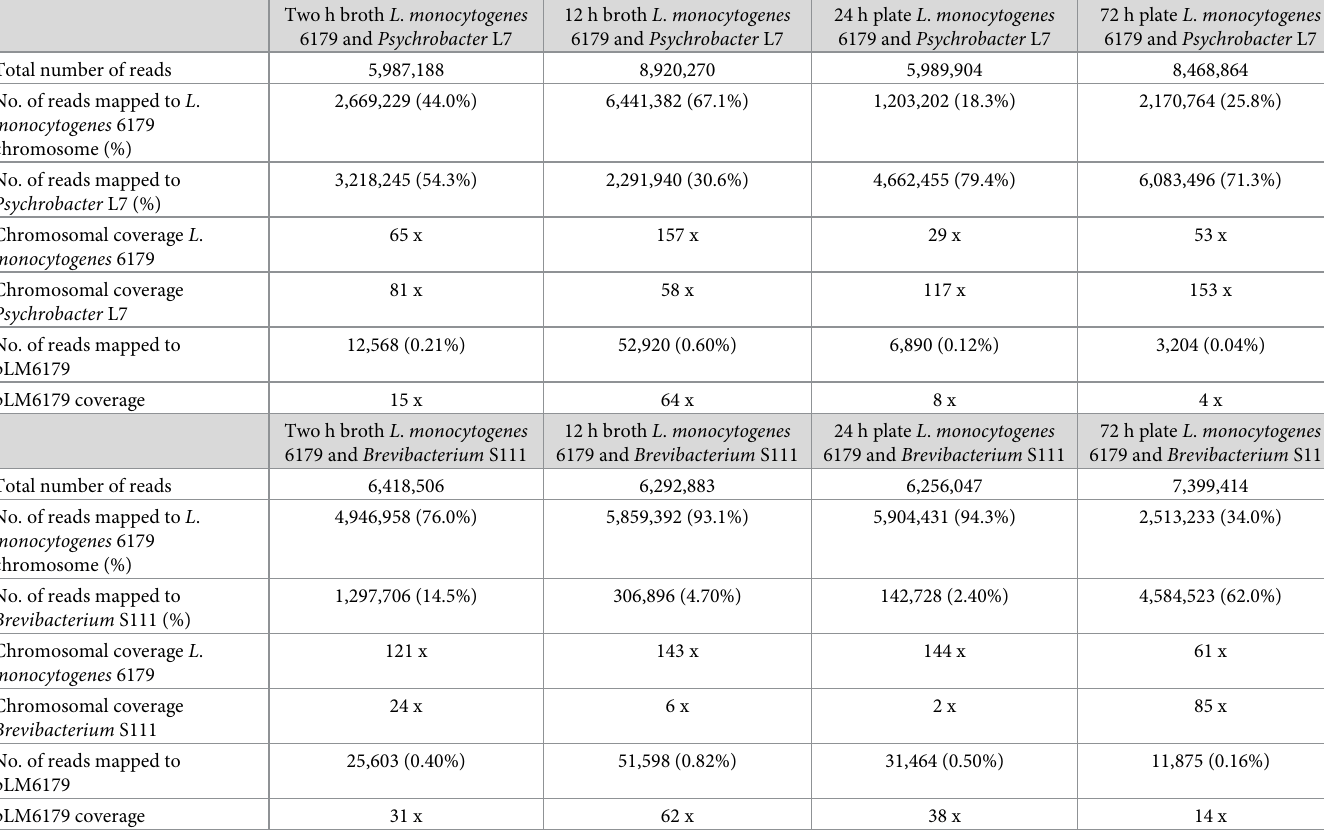
Table 3. Read statistics for L . monocytogenes co-cultivations from sequenced